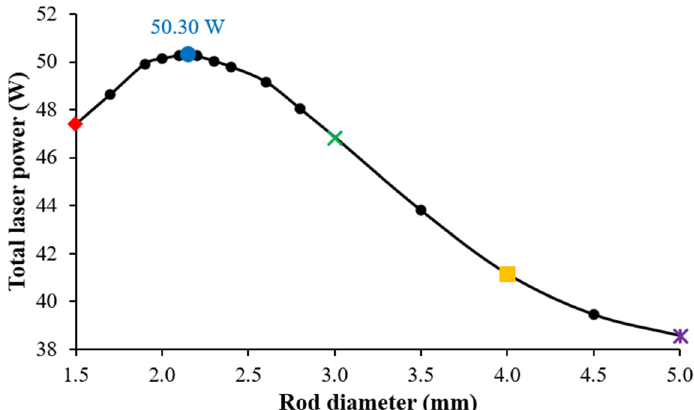
Figure 6. Total laser power in multimode regime as a function of rod diameter. Five configurations were selected to study tracking error compensation capacity and power stability: D = 1.50 mm, D = 2.15 mm, D = 3.00 mm, D = 4.00 mm, and D = 5.00 mm.